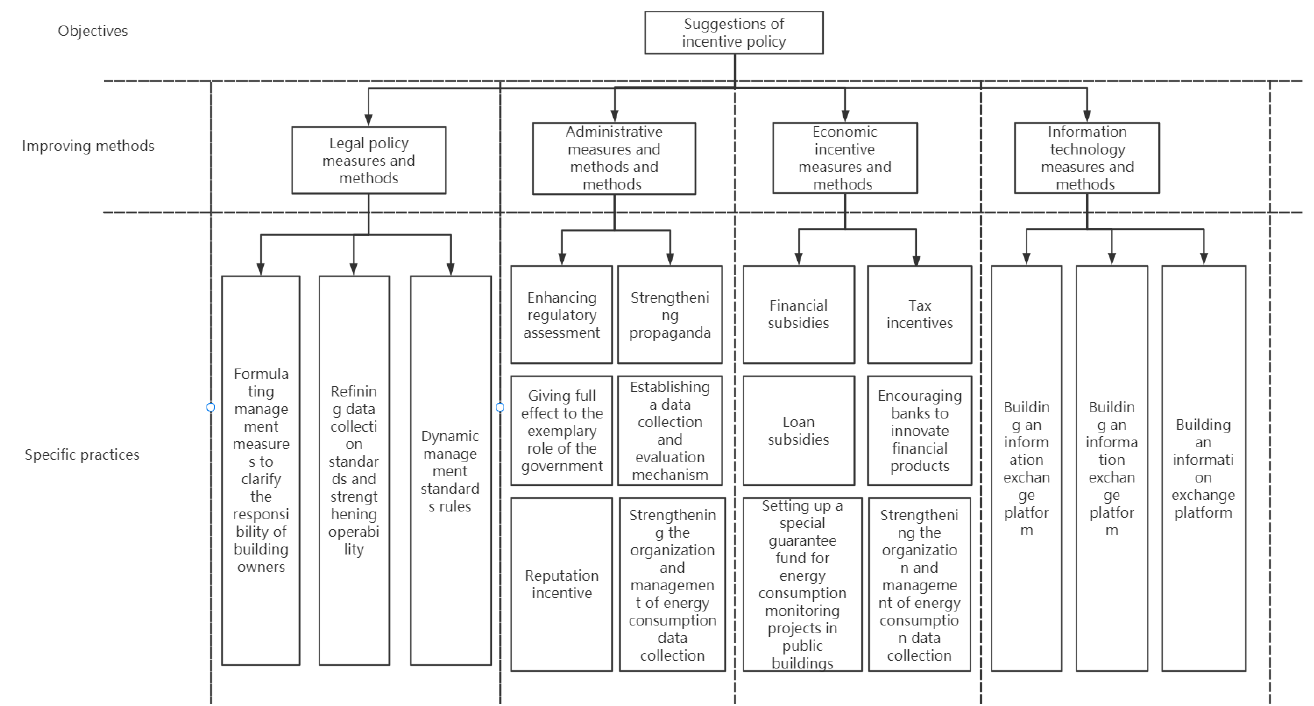
Figure 5. The basic framework of CMECPB ’ s incentive policy recommendations.